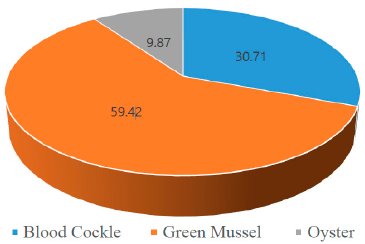
Figure 1. Thailand’s total bivalve cultivation from aquaculture in 2016.